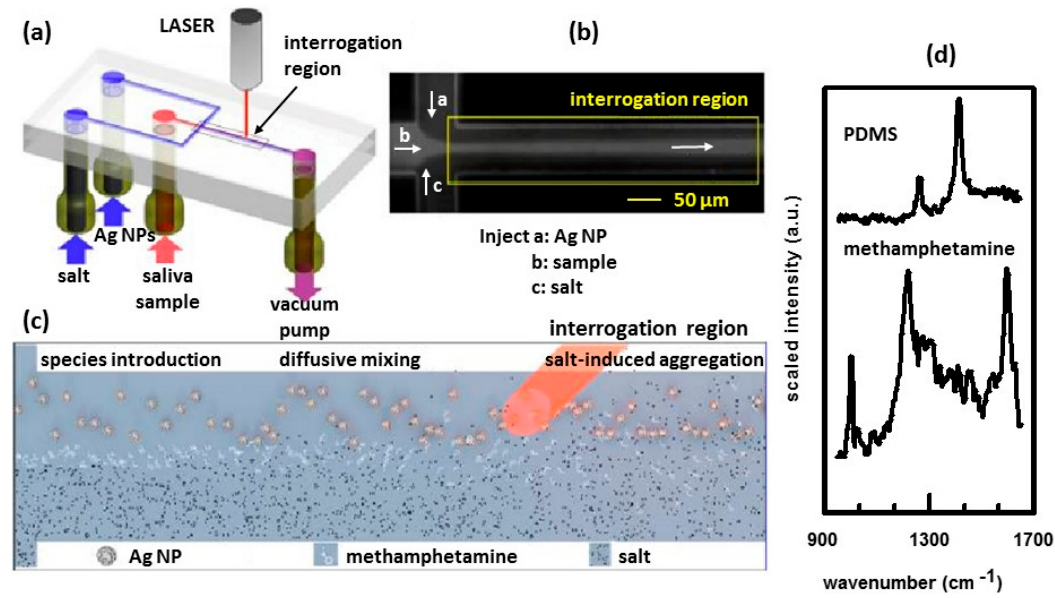
Figure 3. ( a ) Schematic of the flow-focusing microfluidic device used for controlled Ag-NP aggregation; ( b ) Microphotograph of the flow-focusing junction; ( c ) Schematic of the reactions occurring between the analyte, Ag NPs, and salt ions; ( d ) Raman spectrum of PDMS that comprises the channel is shown as well as the SERS spectrum of methamphetamine in the channel. Reproduced with permission from American Chemical Society, 2013 [65].